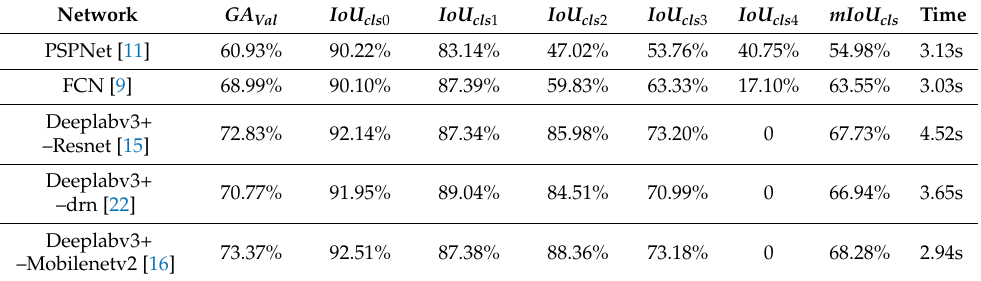
Table 2. The metrics results and test time of several networks based on the cross-entropy loss